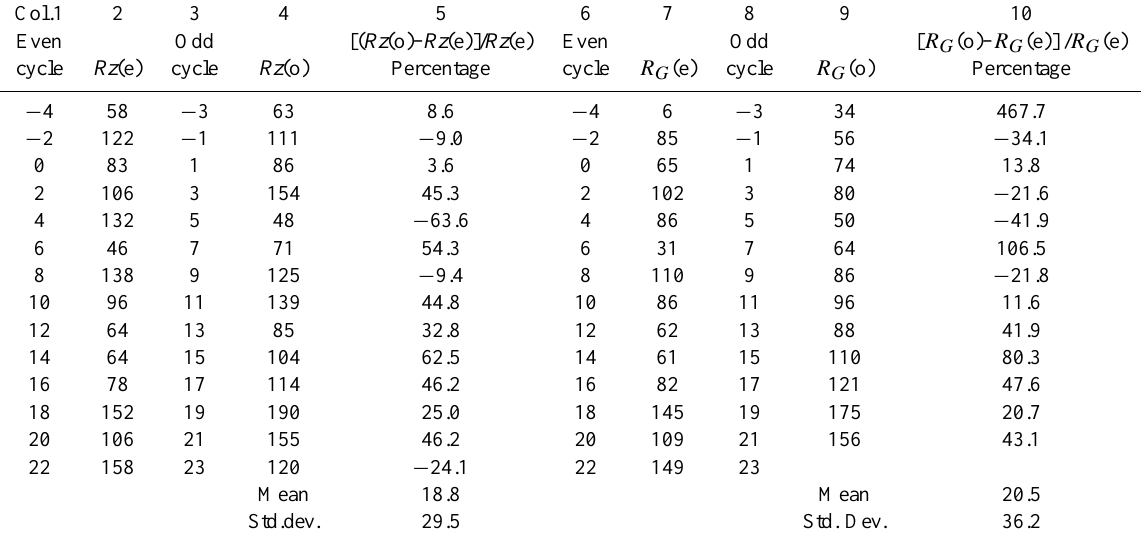
Table 2. The G-O effect for even-odd pairs. In the left half, successive even(e)-odd(o) cycles (columns 1 and 3) and their Rz (e) and Rz (o) values (columns 2 and 4) are given and the percentage excess of the value of the odd cycle over the value of the preceding even cycle [( Rz (o)– Rz (e))/ Rz (e)] is indicated (fifth column). In the right half, similar values are given for R G .